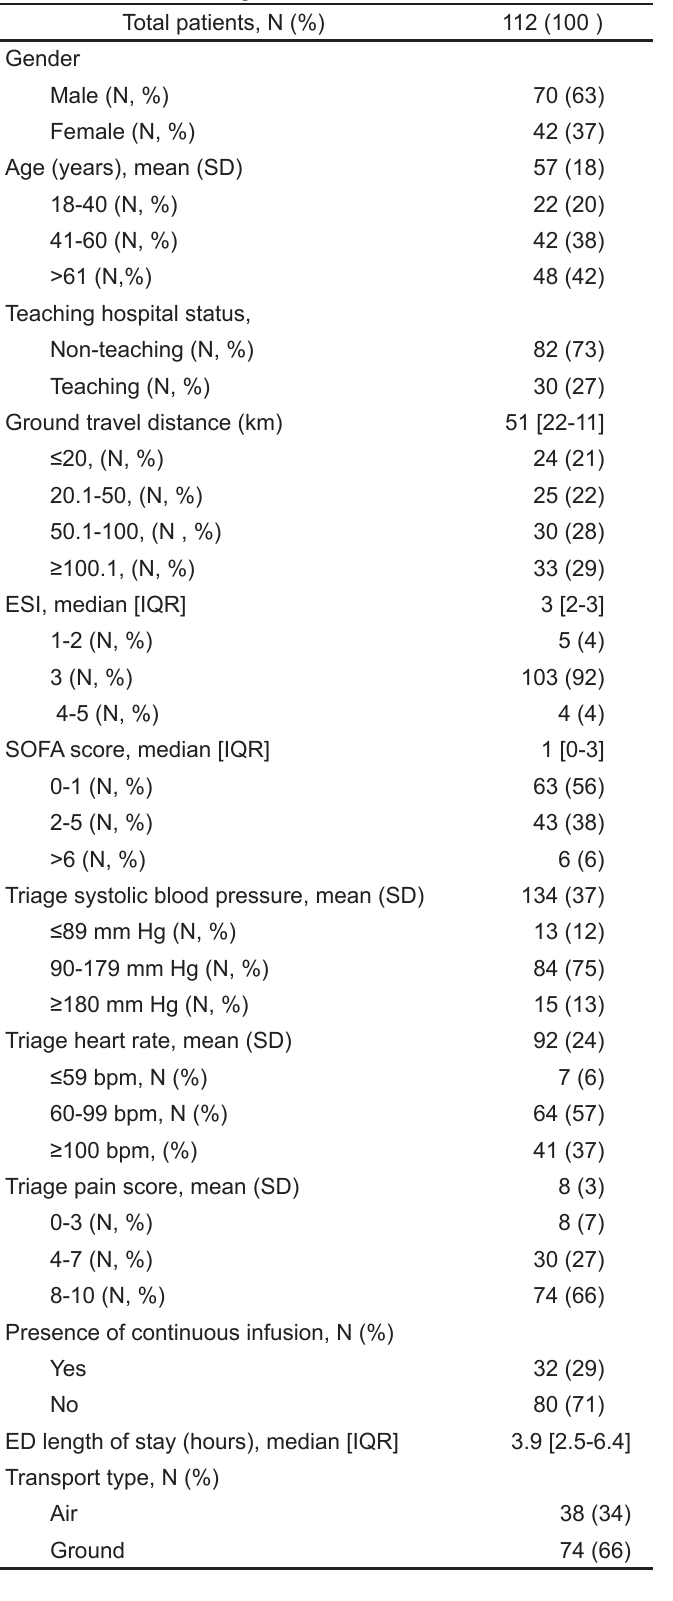
Table 1. Demographic information from 112 patients who were transferred to an Intensive care unit at a tertiary referral academic center and underwent surgical interventions within 12 hours of